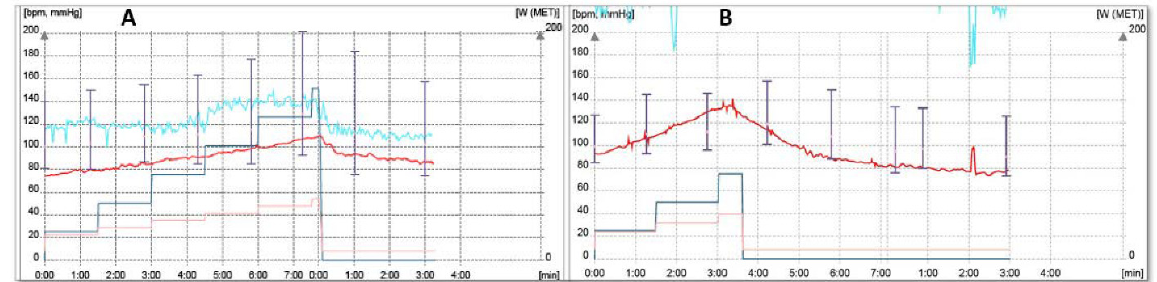
Figure 3. ( A ) Heart rate diagram (red line) during exercise shows a small and slow increase in heart rate during prolonged exercise. ( B ) One month after medication optimization, the ET was